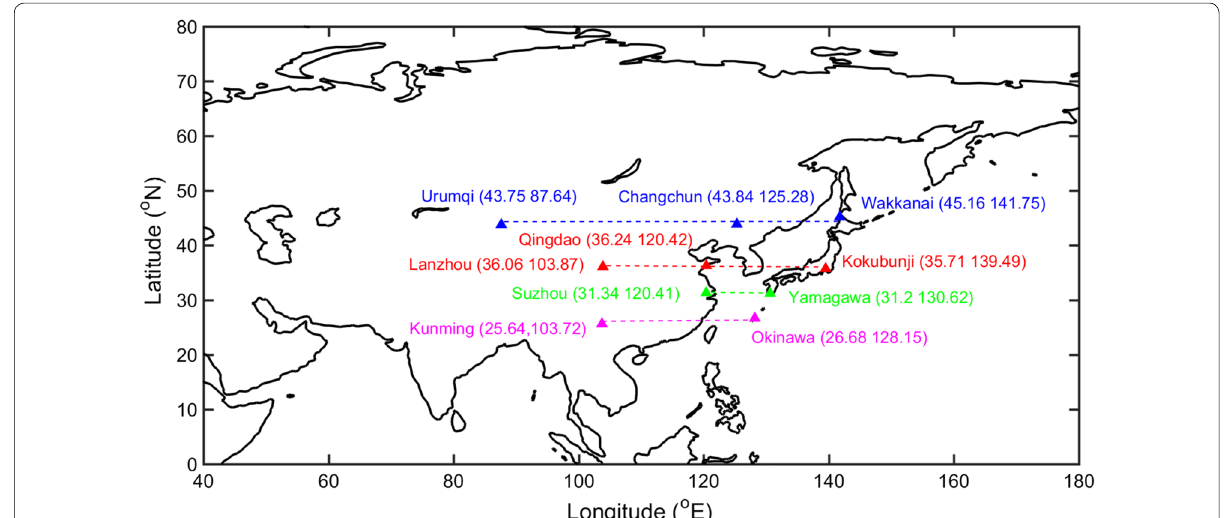
Fig. 1 Details of the digital ionosonde sites used in the investigation; these stations are located roughly at latitudes of 25, 31, 35 and